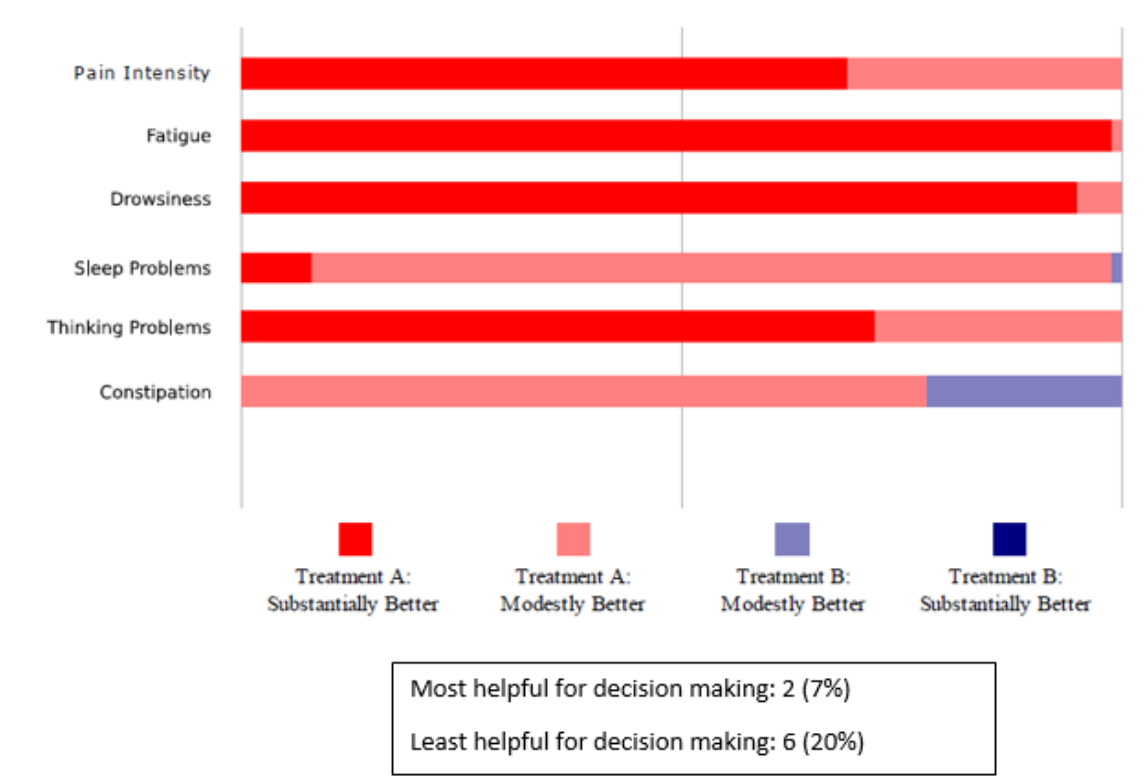
Figure 7. Likelihood that one treatment is better than the